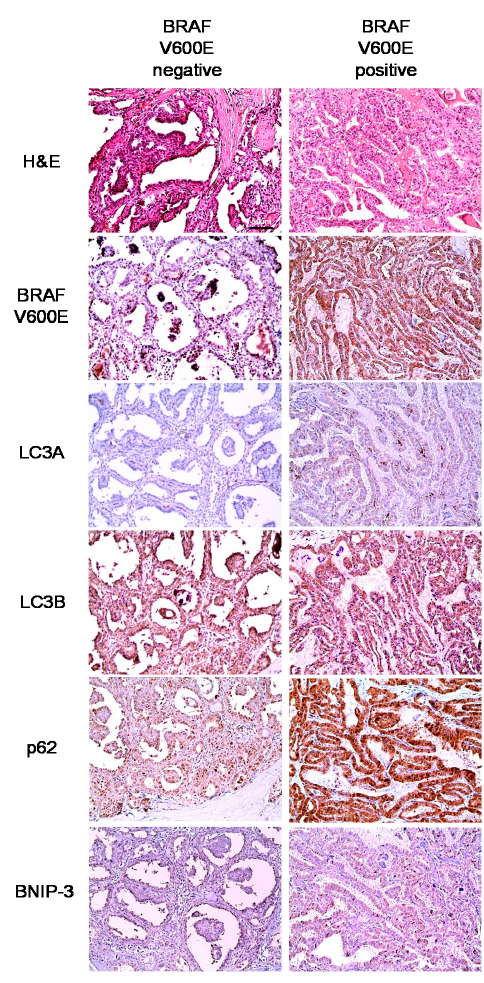
Figure 2. Expression of autophagy-related proteins in papillary thyroid carcinoma (PTC) according to the status of BRAF V600E mutation (Original magnification × 200; Scale bar, 50 µ m). Table 3. Expression of autophagy-related proteins in follicular neoplasms.